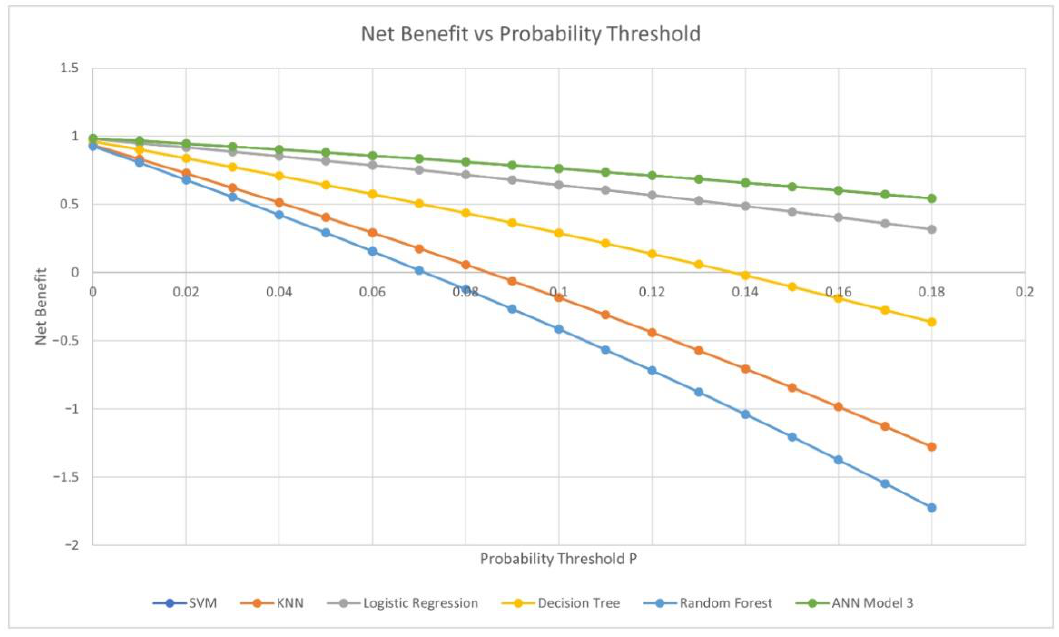
Figure 7. Net benefit of each model.